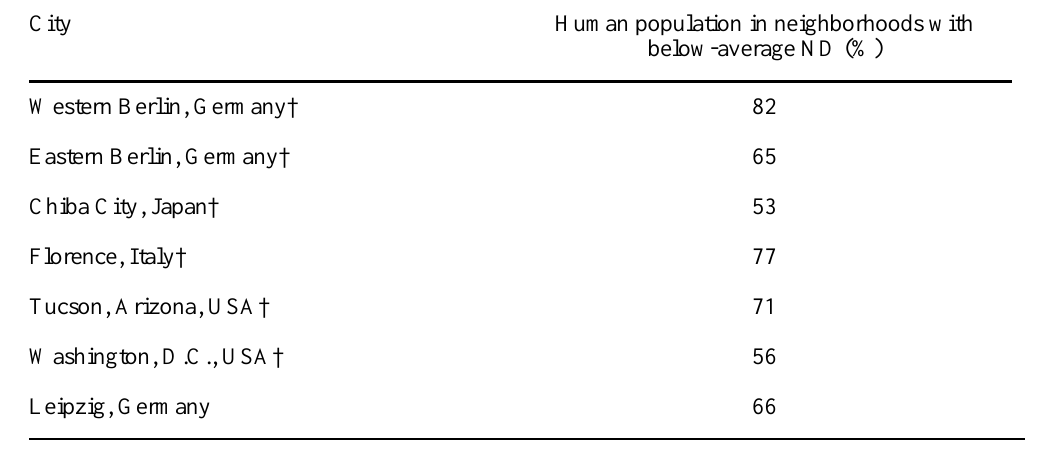
Table 3. The percentage of human population in neighborhoods with below-average neighborhood bird diversity